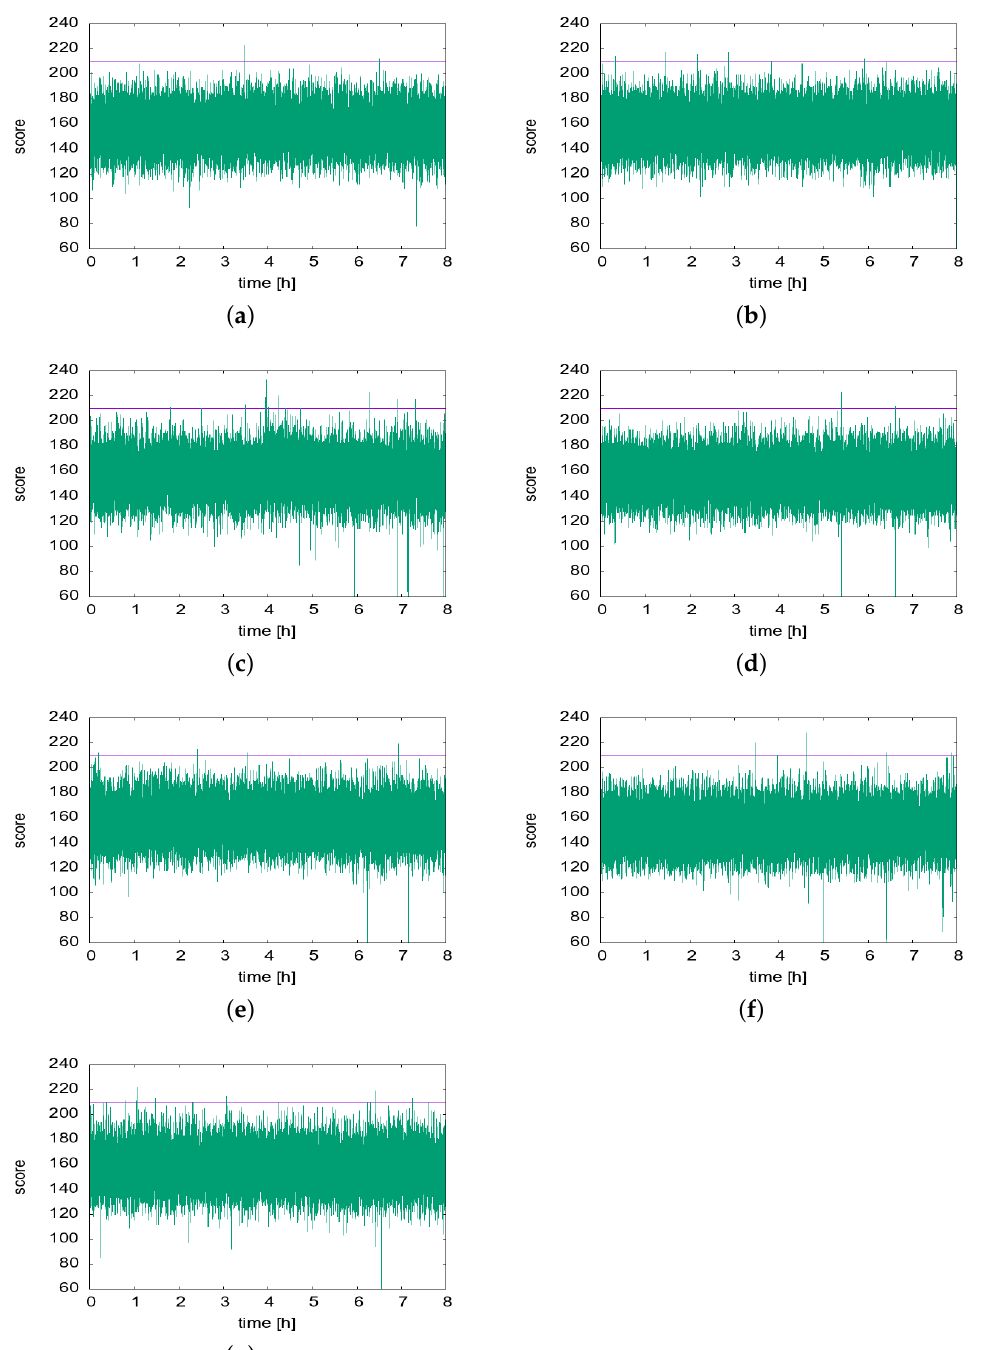
Figure 12. Daily “Mosquito” scores: ( a – g ), respectively, correspond to 24 May 2022 through 30 May